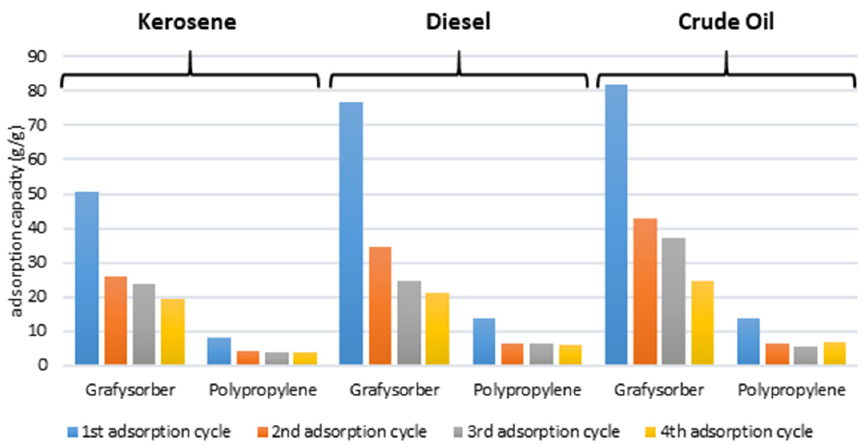
Figure 11. Adsorption capacity after a few regeneration cycles.